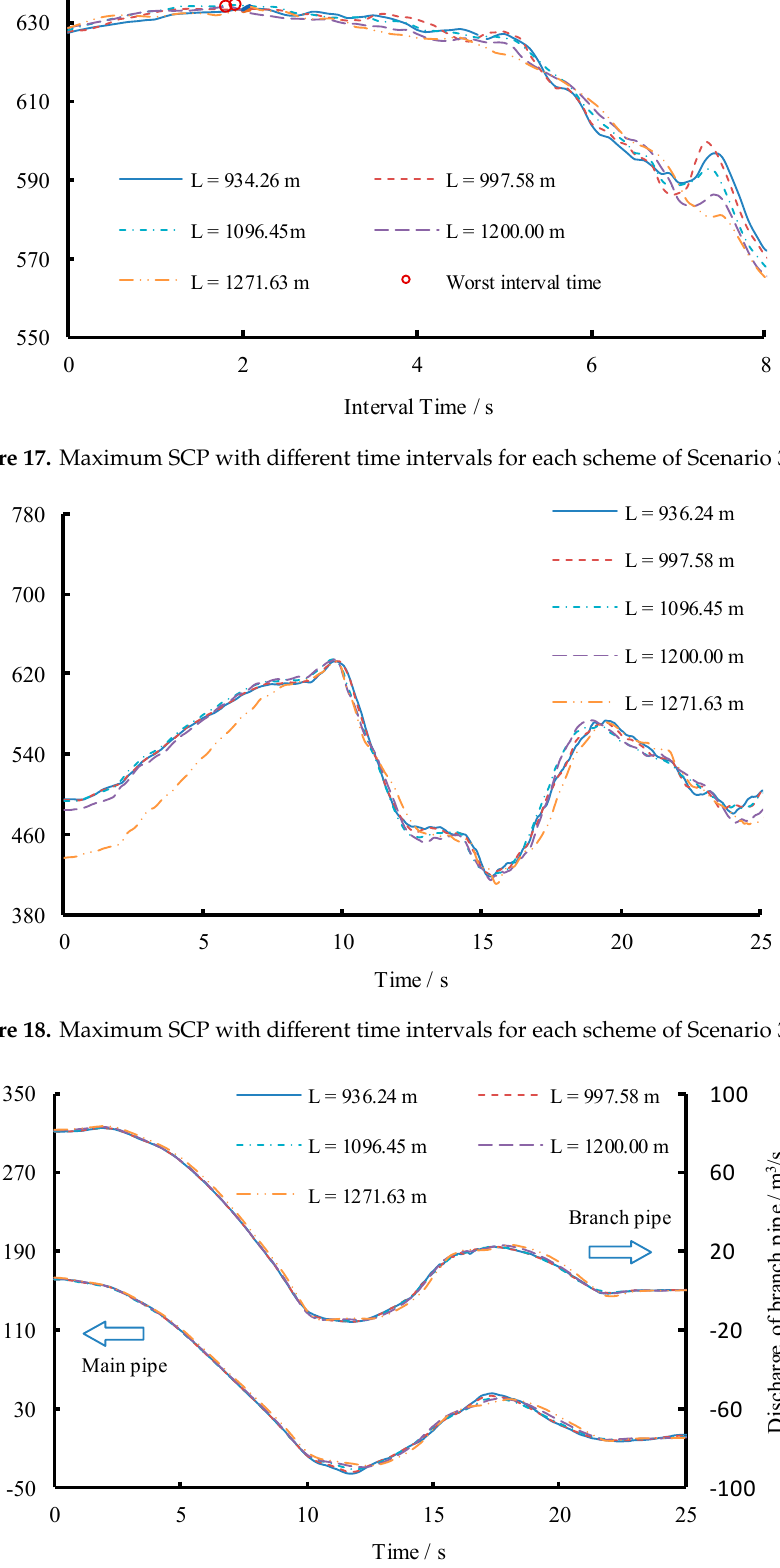
Figure 19. Main and branch pipe discharge versus time for each scheme of Scenario 3 during TLR.